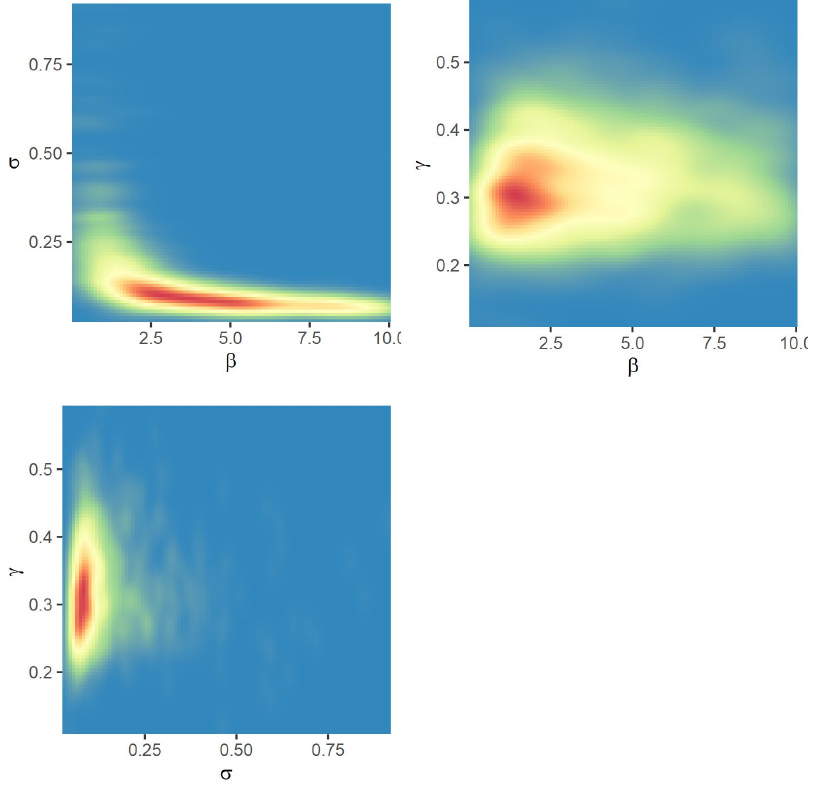
Figure A1. Heat map of the pair-wise correlations between parameters in the approximate posterior distribution.